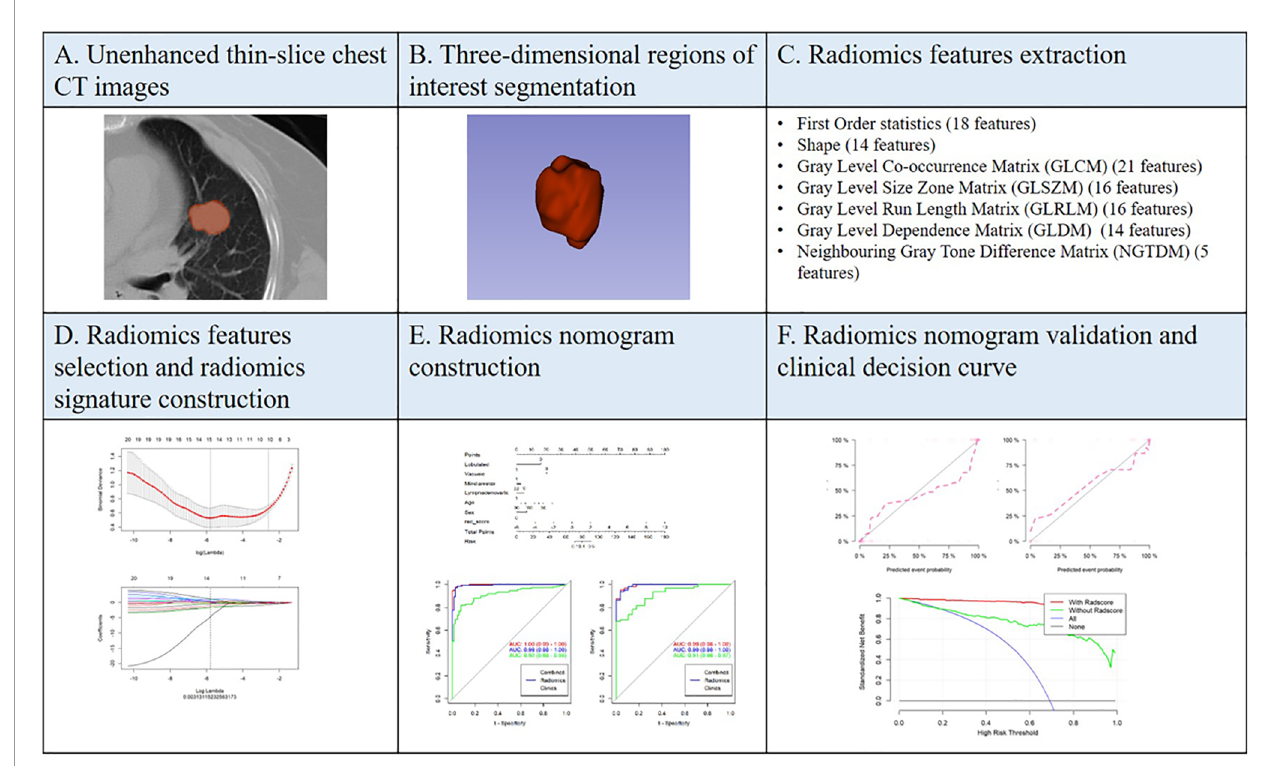
FIGURE 2 | Overview of the study